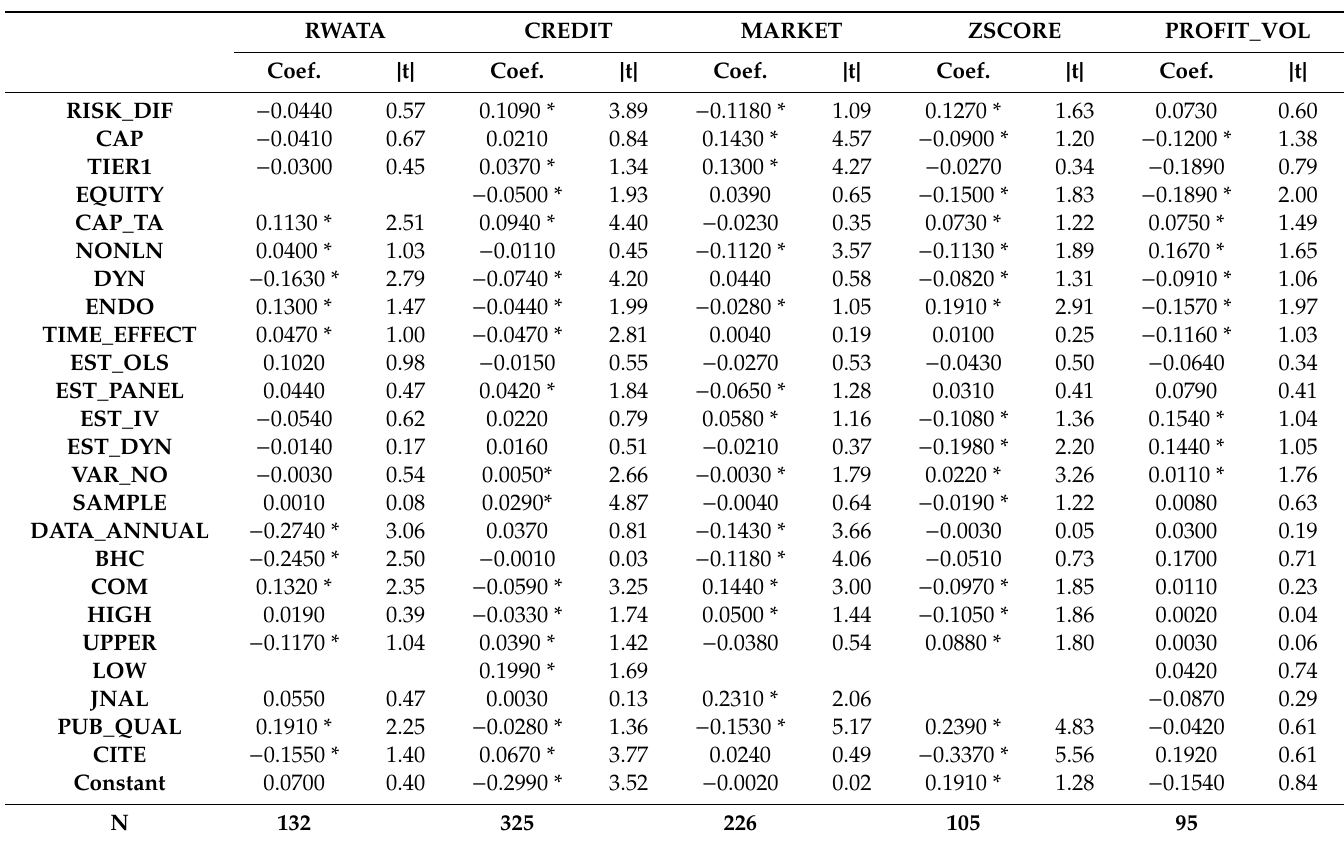
Table 5. WALS Estimations on Di ff erent Risk